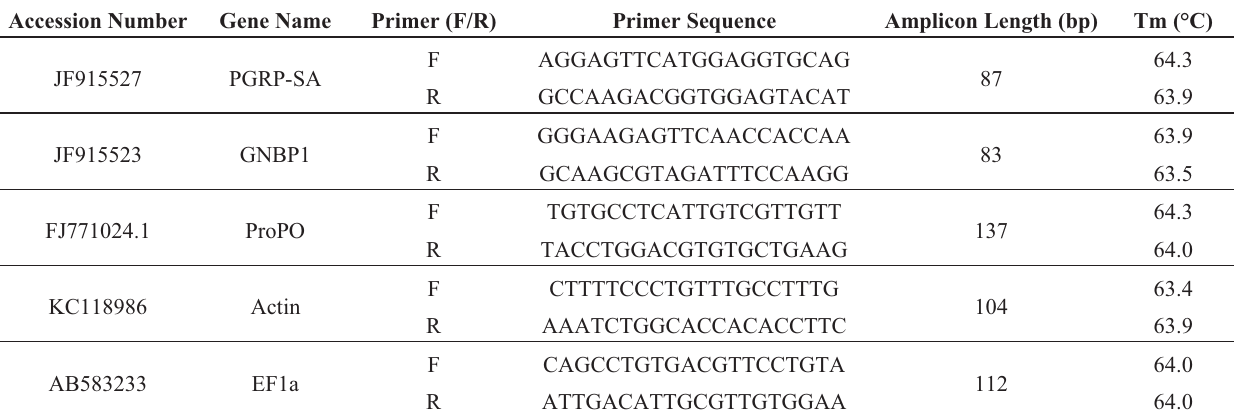
Table 1. Primer sequences for immune genes encoding peptidoglycan recognition protein SA (PGRP-SA), gram-negative bacteria binding protein 1 (GNBP1) and prophenoloxidase (ProPO) used in RT-qPCR gene expression assays. Reference genes (Actin and EF1a) were used to normalise relative expression. Amplicon length, melting temperature and accession numbers are